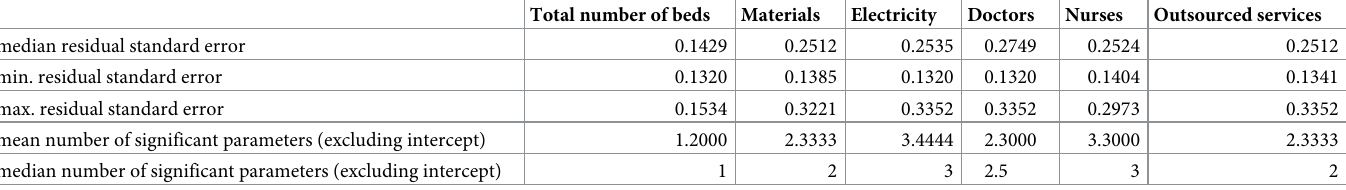
Table 5. Comparison of adjustment of three-factor translog function by explanatory